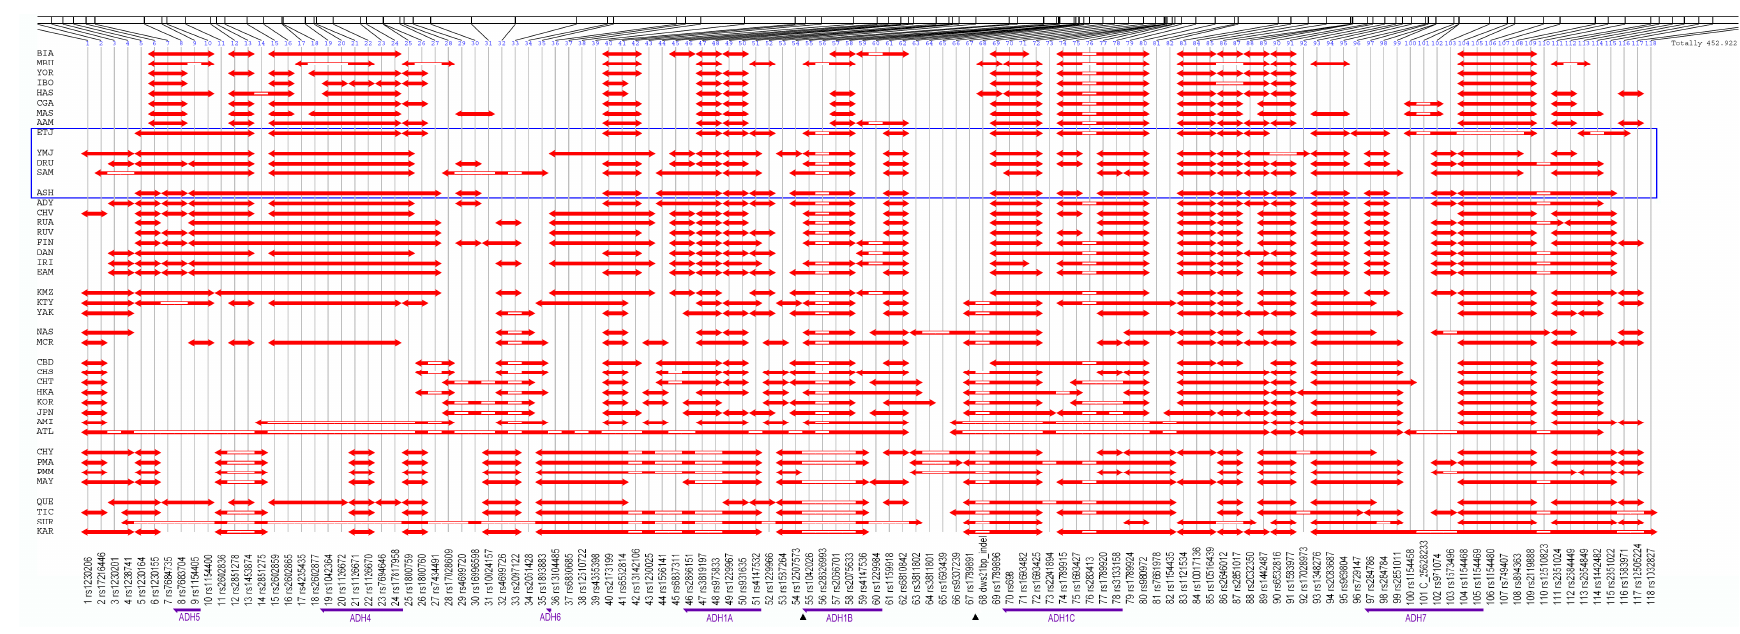
Figure 2. The schematic representation of regions of high linkage disequilibrium (LD) across the human alcohol dehydrogenase ( ADH ) clusters. HAPLOT and the default r 2 algorithm were used. All 118 genetic markers (including one insert-deletion site treated as a single nucleotide polymorphism (SNP)) are listed at the bottom. The locations of two short tandem repeat polymorphisms (STRP) loci are indicated at the bottom by the black triangles. The arrow above each gene symbol indicates the downstream direction; the region is plotted from centromere to telomere. Generally speaking, populations of the same group have similar LD structure with some variation. Highlighted within the blue box, Southwest Asian populations show LD patterns similar to those of European and African populations.